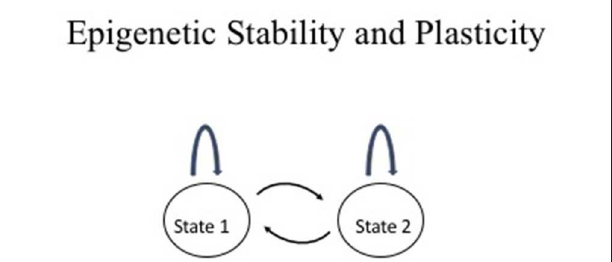
FIGURE 1 | Epigenetic stability vs. plasticity. The two states may represent any two conceptual epigenetic states such as an active chromatin vs. an inactive chromatin state or normal cell vs. cancer cell. The arc above the state represents maintenance of the state through events such as mitotic division whereas the arrows between the two states represent interconversion between the two states such as changes in chromatin structure during cellular differentiation, physiological response, or